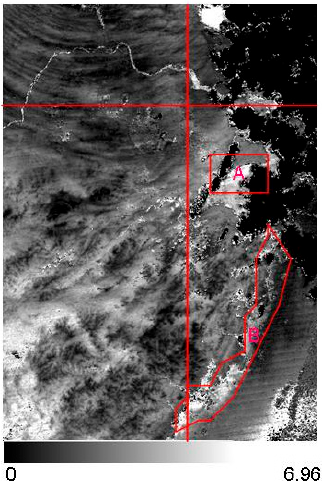
Figure 4. Water vapor content retrieved by NN.